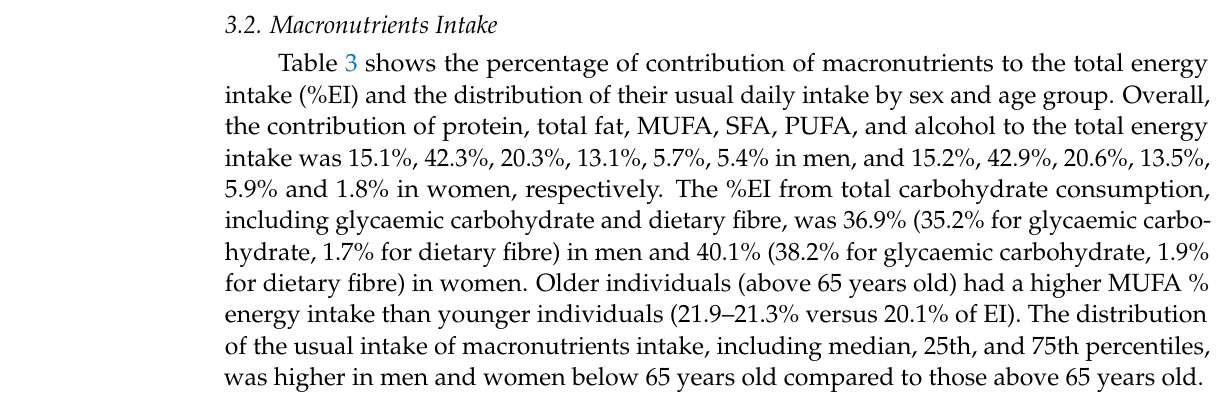
Table 3. Energy percentage intake (%EI), median, and percentiles (25th and 75th) distribution